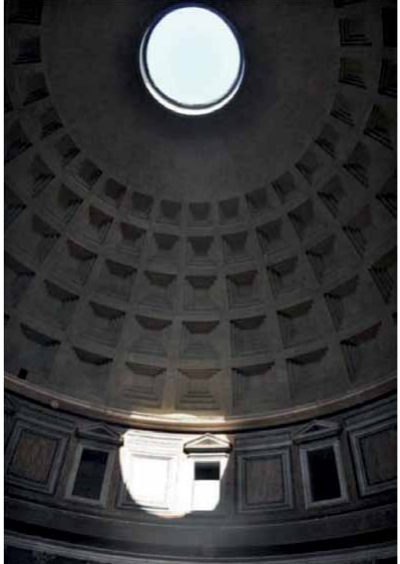
fig. 3. Pantheon Temple Table 1. role of natural light in determining the quality – identity of architectural space Determination of the quality – identity of architectural space by natural light Dimension of natural light’s contribution to the Dimension of natural light’s readability of the space Dimension of natural light’s contribution to the aesthetical contribution to the effect of Natural light as a guiding the space evaluation of the space Natural light as a tool for expressing spatial elements tool in the space